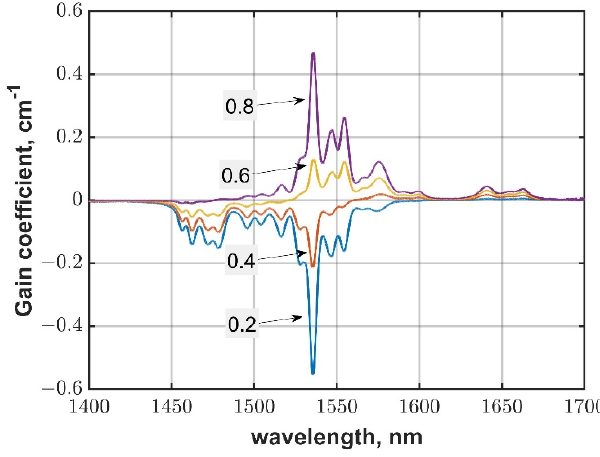
Figure 9. Gain spectra of Er 3+ :Y 2 O 3 optical ceramics for inversion parameters. β = 0.2–0.8.